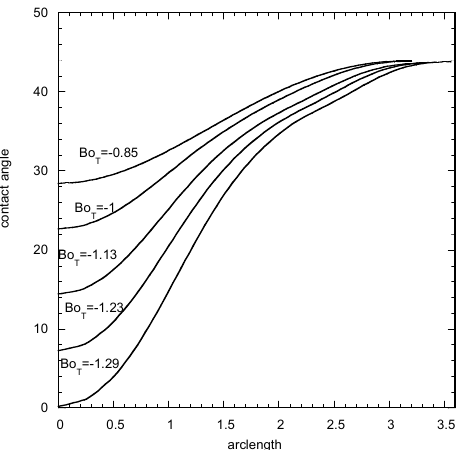
Figure 8. Evolution of contact angle distribution along the contact lines by inversing the direction of the tangential Bond number at the inception of spreading (linear Young–Laplace equation, V = 0.6).